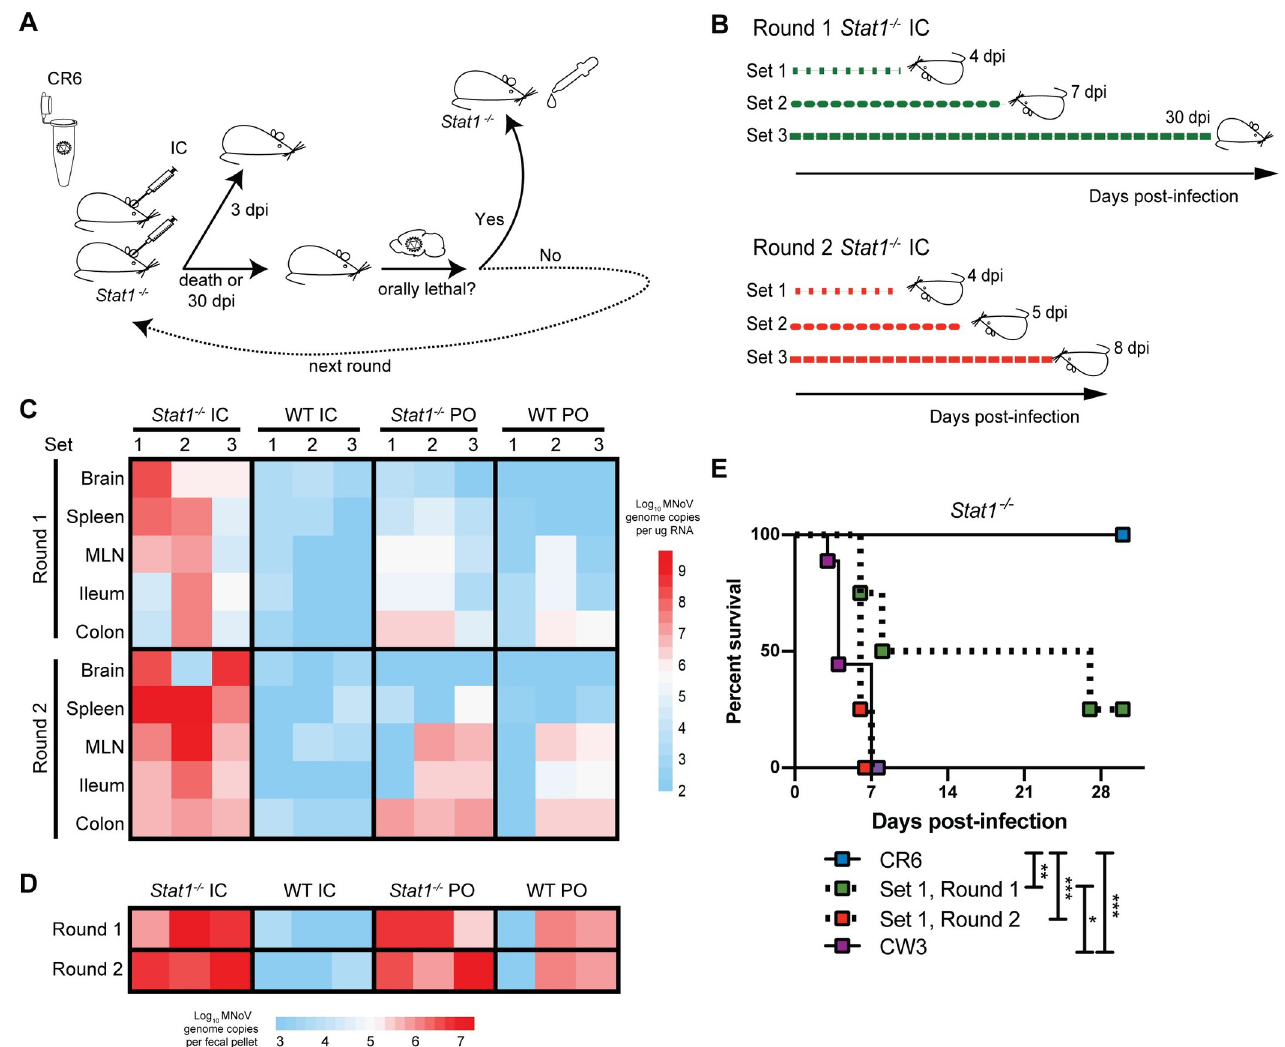
Fig 1. Intracranial passaging of murine norovirus in Stat1 -/- mice promotes systemic spread and acquisition of lethality. (A,B) Schematics of intracranial passaging protocol, initiated with 10 6 PFU CR6, conducted in three parallel “sets” of Stat1 -/- mice (A) , and of timing of spontaneous lethality or tissue collection for the three sets of mice (B) . (C,D) Heatmaps depicting MNoV genome levels detected by quantitative RT-PCR (qPCR) in designated tissues (C) or stool (D) at time of death as shown in (B) , with values ranging from log 10 1.95 to 9.61 (limit of detection at 2.0) for tissues and log 10 2.95 to 7.12 (limit of detection at 3.0) for stool. Each square indicates a single mouse tissue from 24 total mice analyzed. (E) Survival curve of Stat1 -/- mice orally administered 10 6 PFU CW3 or CR6, or a 1:80 dilution of brain homogenate from Set 1 Round 1 or Round 2 mice. n = 4–9 mice per group over two independent experiments, analyzed by Mantel- Cox test. ��� , P < 0.001; �� , P < 0.01; � , P < 0.05; ns, not significant.